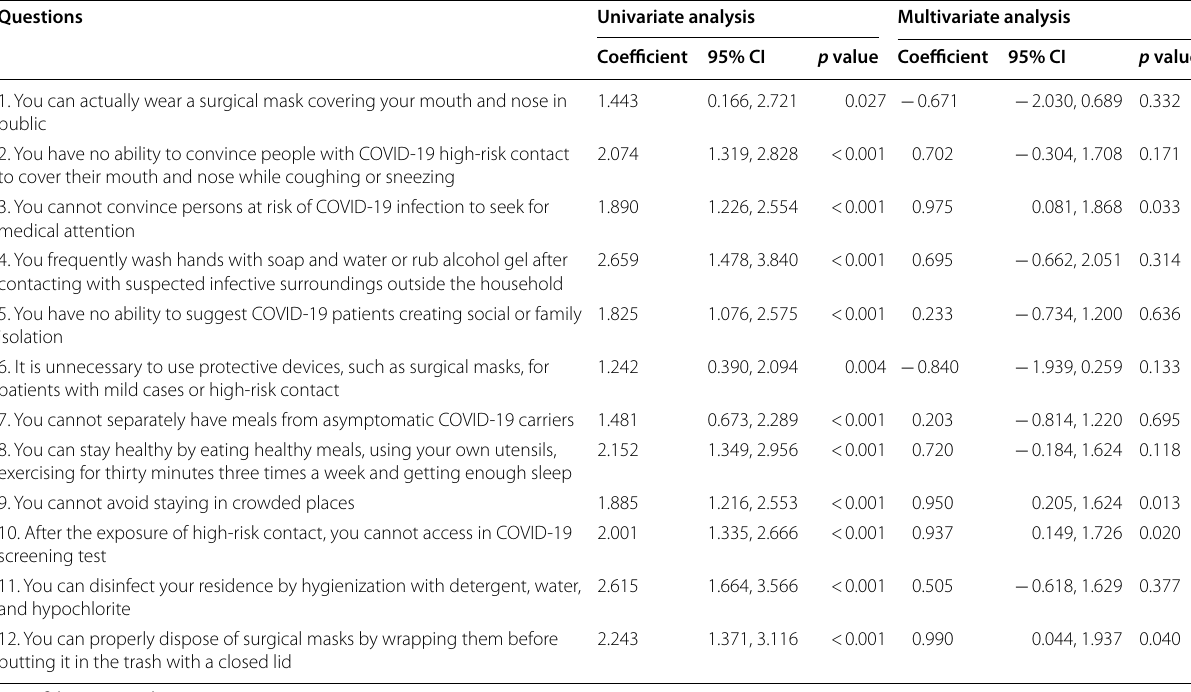
Table 6 Factors associated with preventive behaviors of COVID-19 infection by questions on perception of personal preventability to prevent COVID-19 infection in healthcare